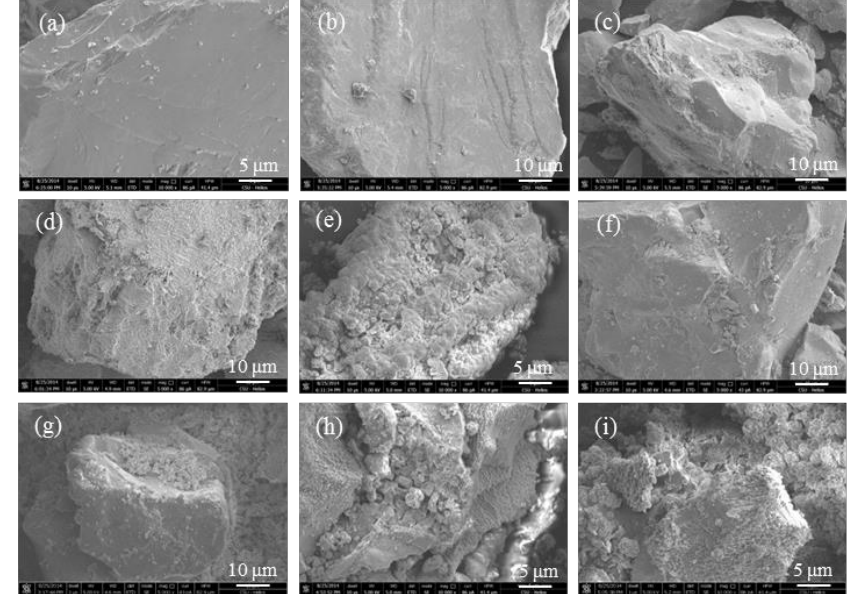
Figure 4. Scanning electron microscopy (SEM) micrographs of original chalcopyrite ( a ) and chalcopyrite bioleached by mesophilic culture without Ag + on day 12 ( b ) and day 28 ( c ) and in the presence of 0.3% Ag + on day 12 ( d ) and day 28 ( e ); SEM micrographs of chalcopyrite bioleached by thermophilic culture without Ag + on day 12 ( f ) and day 28 ( g ) and in the presence of 0.3% Ag + on day 12 ( h ) and day 28 ( i ).